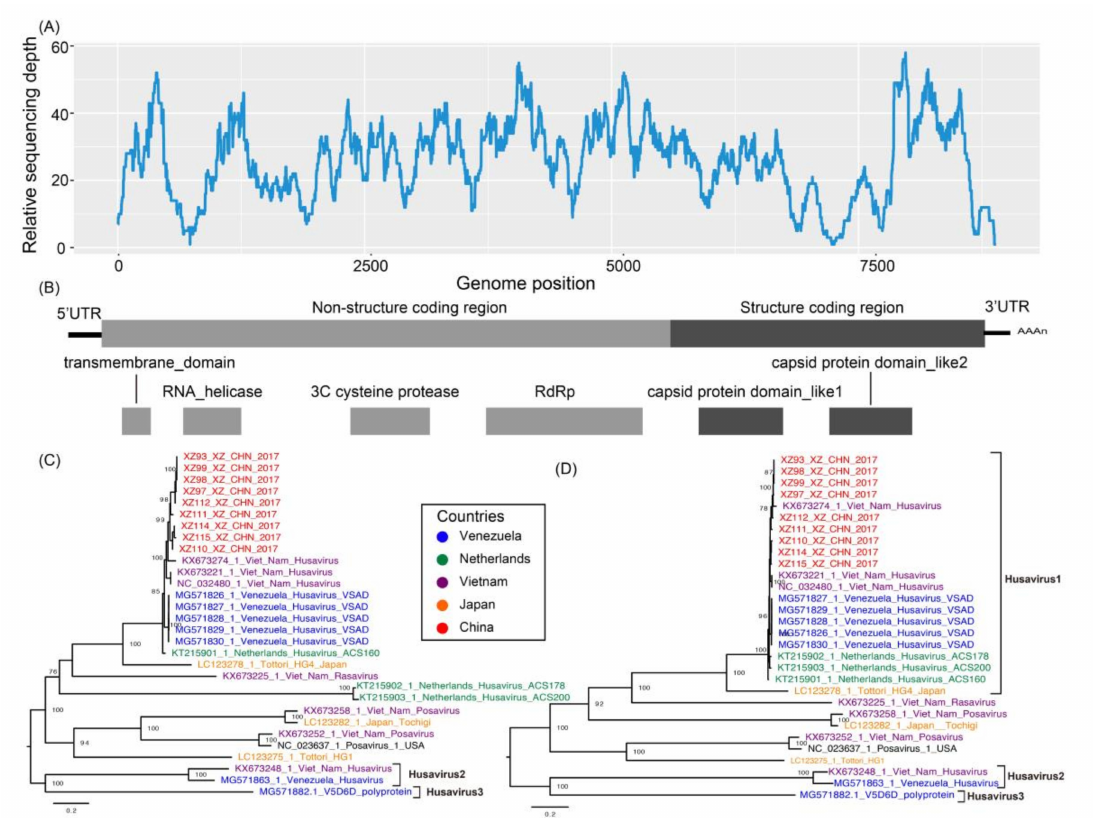
Figure 2. ( A ) Relative sequencing depth across the reference genome. ( B ) The classical genomic organization of posa-like viruses. ( C ) The maximum-likelihood phylogenetic tree of husaviruses and the neighboring posa-like viruses, constructed using nucleotide sequences. ( D ) The maximum-likelihood phylogenetic tree of husaviruses and the neighboring posa-like viruses was constructed using amino acid sequences. Scale bars indicate the substitutions per site per year, and taxa are colored according to the countries of origin. The box show the previously reported Husavirus 1 strain. The numbers at each node indicate the bootstrap support value, with 1000 bootstrap